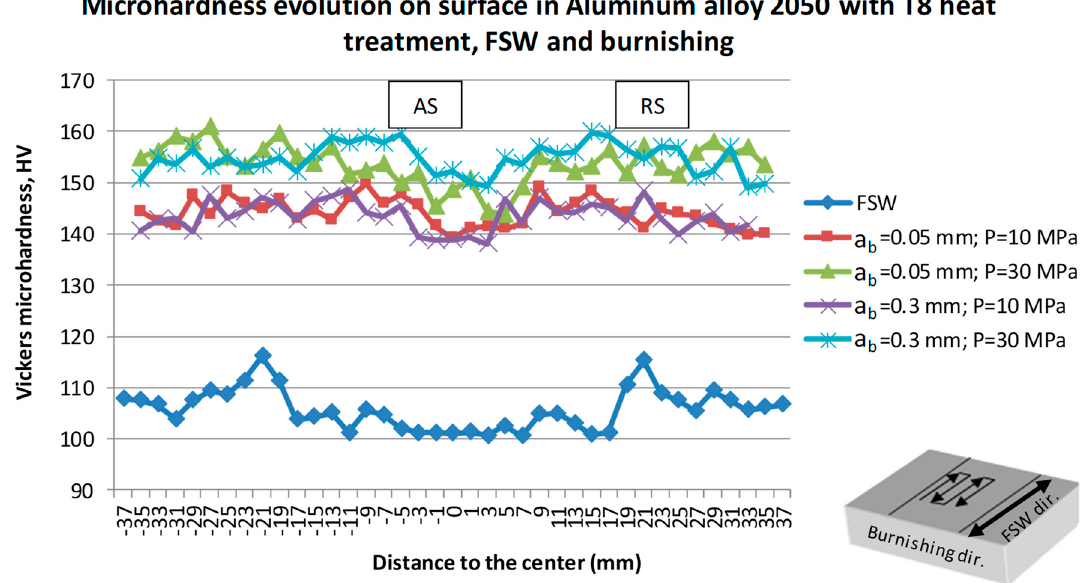
Figure 14. Microhardness evolution with burnishing applied parallel to the welding direction.